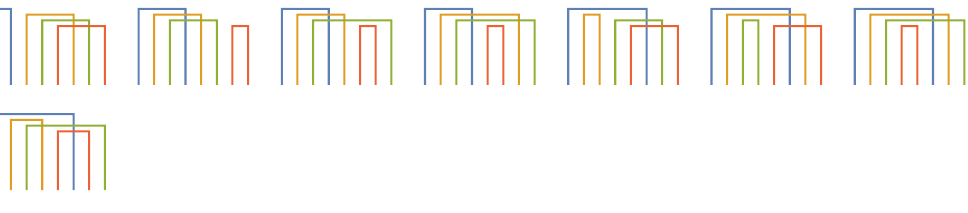
Figure 12 . Diagrams with three intersections contributing to the 8th moment as T 6 .